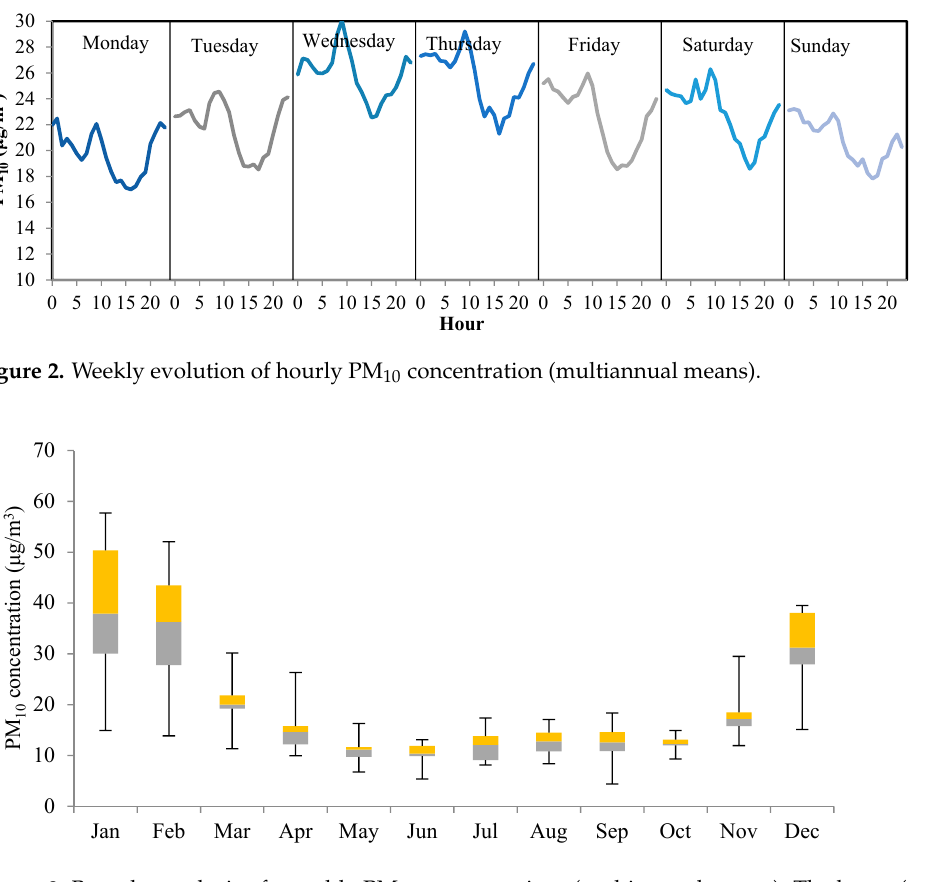
( b ) Figure 4. Annual ( a ) and seasonal ( b ) mean PM 10 concentration. 4.b Box-plot analysis of seasonal PM 10 concentrations The lower (grey) and upper (yellow) limits represent the first (25P) and third (75P) quartiles, and the ends of the whiskers represent the minimum and the maximum values. According to the calculations, the increased PM 10 concentration depends on the high changes in the winter and summer boundary layer and from the increased emission from heating in the winter period. During the winter, PM 10 concentration increased by an aver- age of 9.36 μ g/m 3 due to the heating season. According to the PM 10 classification (low, moderate, high and very high concentra- tion), the PM 10 concentration was higher than 50 μ g/m 3 in 177 cases; 88% of them were in